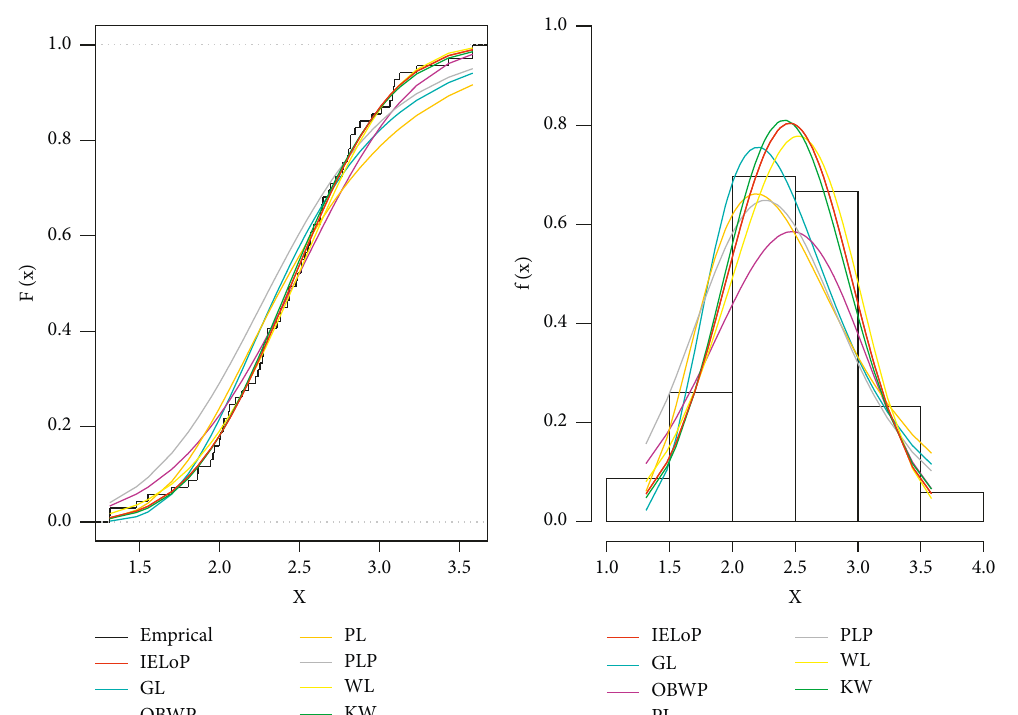
Figure 5: Estimated cdf and pdf for different distributions for dataset